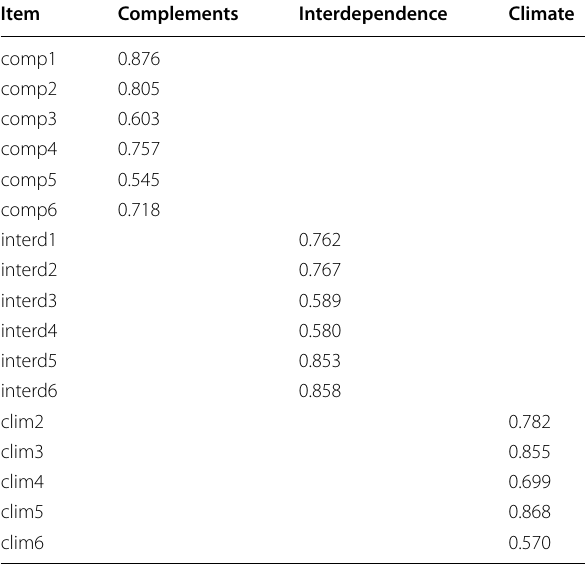
Table 1 Pattern loadings for EFA, item loadings < 0.4